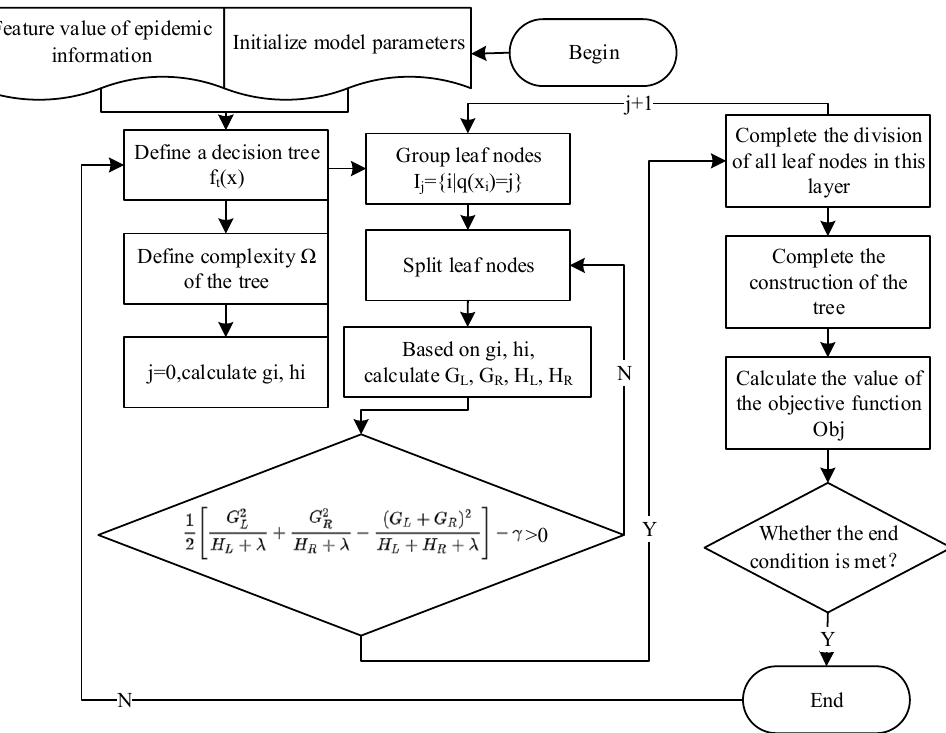
Figure 1. The identification process of fake epidemic information based on the XGBoost